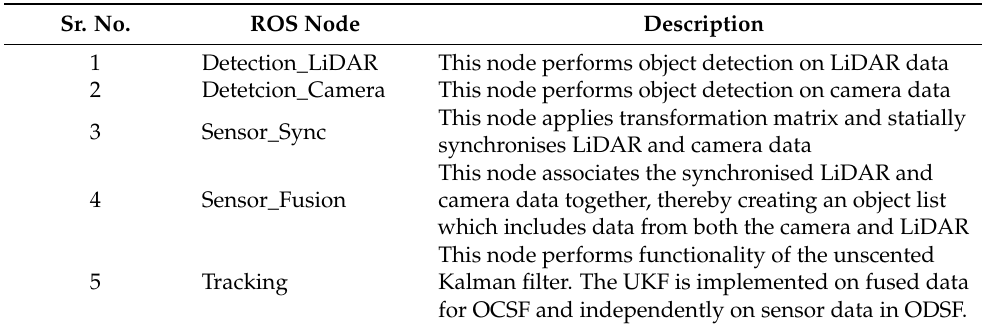
Table 4. Description of ROS nodes for OCSF and ODSF. Sr.